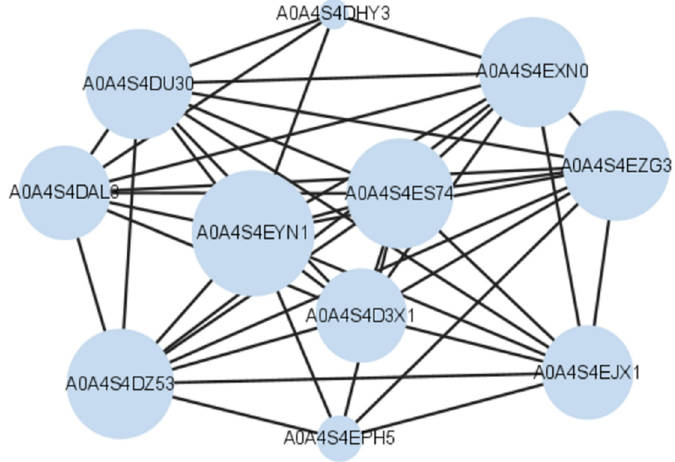
Figure 6. Interactions among 11 detected differential proteins. The size of the circle is positively correlated with the degree of interaction. The interaction was analyzed in STRING and drawn using Cytoscape. Table 2. Detected differential proteins of purple-red cultivars compared with white-yellow cultivars with protein and gene names. Increased change refers to upregulated proteins, and decreased change refers to downregulated proteins.